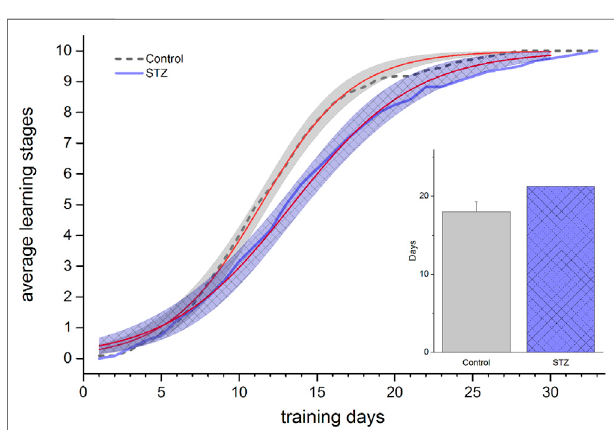
FIGURE 7 | Learning performance in the 5 Choice Serial Reaction Time task in EXP2. Learning curves of control and STZ-treated animals are depicted. Shaded areas show the 95% con fi dence band of the fi tted sigmoidal regression curves (thin [red] lines). The regression lines signi fi cantly differ (no overlap between the con fi dence bands). The column chart inset shows the number of days taken to reach the fi nal stage. Means ± SEM values are shown. No signi fi cant difference was detected between the two groups (unpaired t -test: t (21) (cid:2) − 1.46,